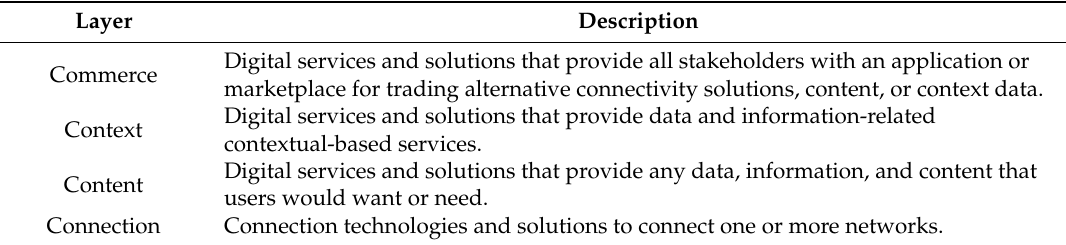
Table 1. The 4C ecosystemic business model and value framework (adapted from